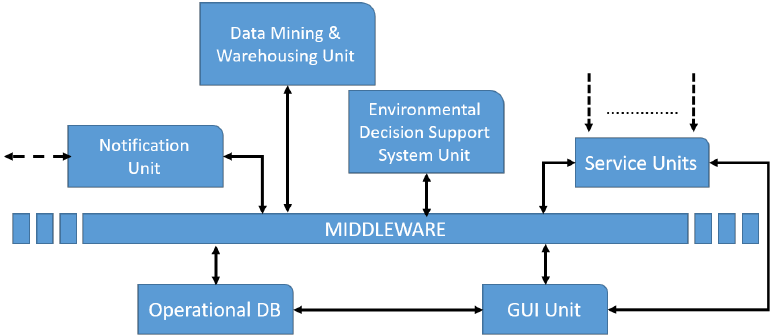
Figure 1. Architectural design of the Marine Information System